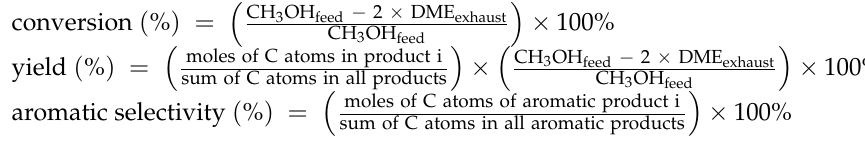
Table S1. Detailed product distribution of tested catalysts at 400 ◦ C with different contact times. Figure S1. Fractional changes of porosity of HZ-D and HZ-DA, using HZ as the reference. Figure S2. Micropore PSD estimated by NLDFT of tested